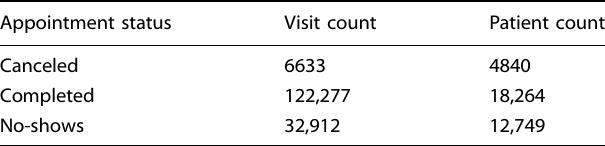
Table 1. Study cohort (appointment status).